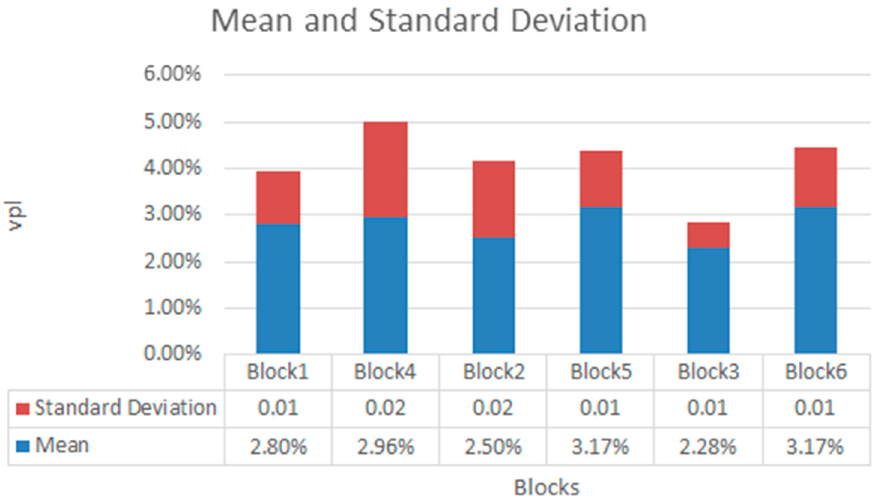
Figure 17. Mean and standard deviation for values of vpl .